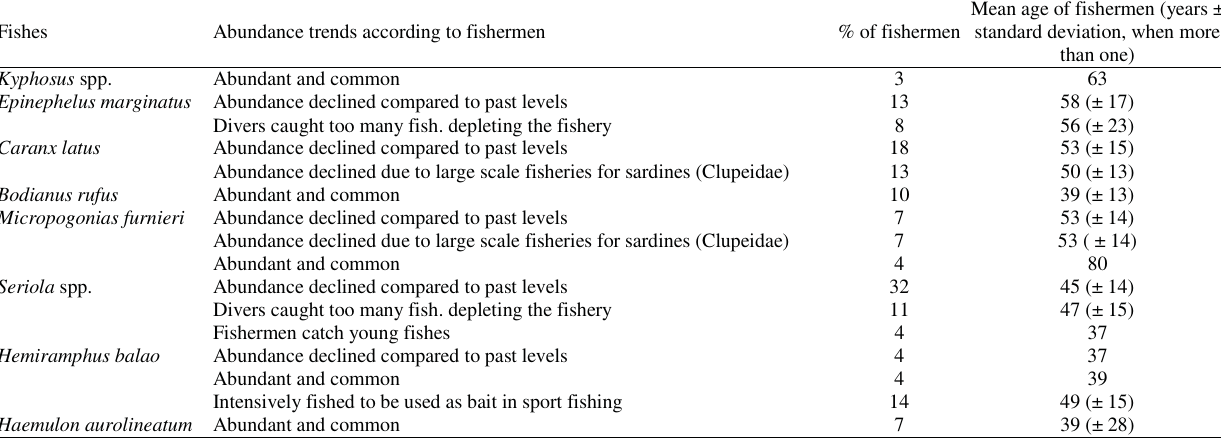
Table 4. Additional information provided by interviewed fishermen about abundance trends of the studied fishes. Total numbers of interviewed fishermen and scientific names of fish species are in Table